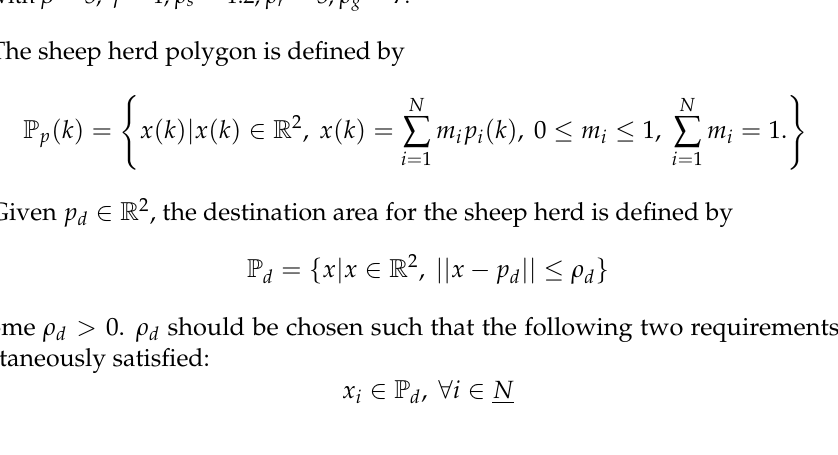
Figure 4. Plots of functions ϕ ( x ) and ψ ( x ) . ( a ) Plot of ϕ ( x ) with α = 1, ρ x = 1.2, ρ vp = 15. ( b ) Plot of ψ ( x ) with β = 3, γ = 1, ρ s = 1.2, ρ r = 3, ρ g =